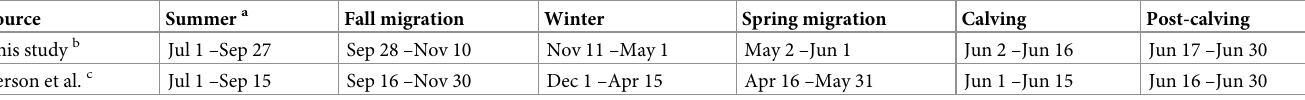
Table 1. Teshekpuk Caribou Herd seasonal boundaries as defined in our study and Person et al.